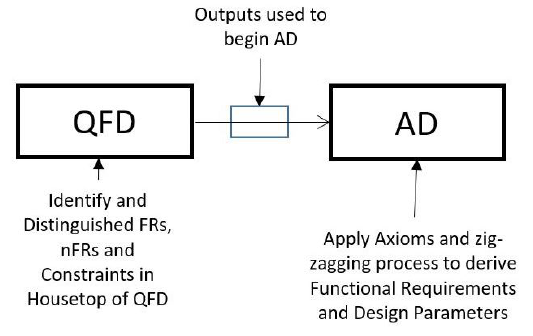
Figure 3. Integration of QFD and AD [25].